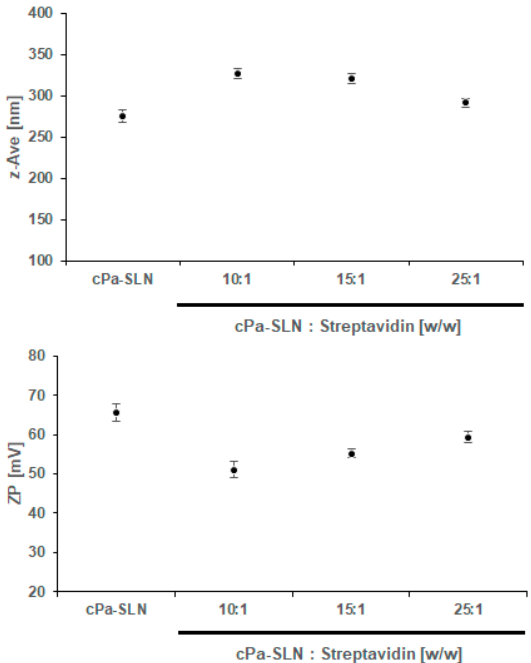
Figure 4. Variation on the mean particle size (z-Ave, upper panel) and zeta potential (ZP, lower panel) of c Pa -SLN- S complexes obtained from different c Pa -SLN—Streptavidin binding ratios. Results are given as a mean from three measurements of three independent experiments.